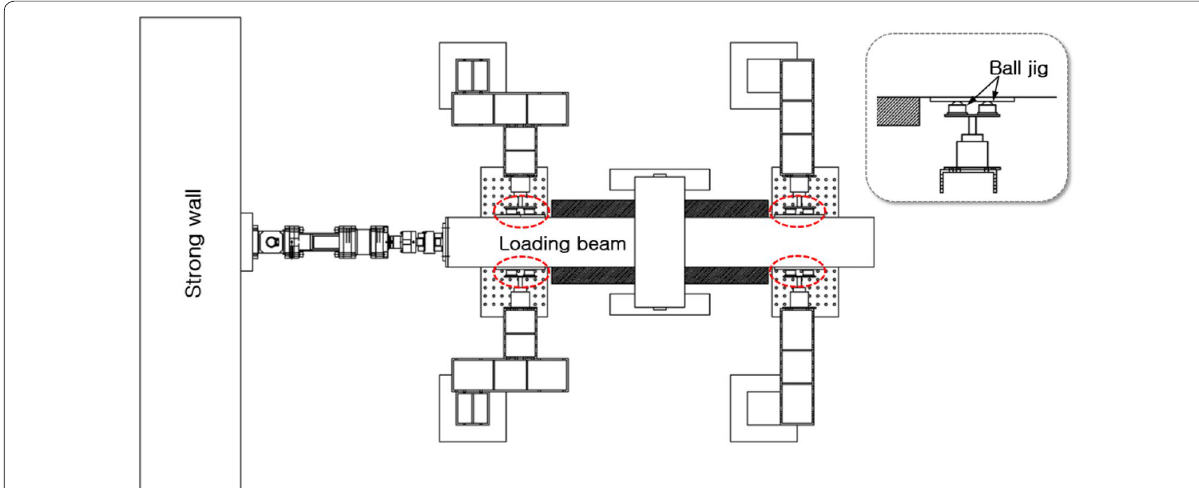
Fig. 7 Guide frame installation for prevention of out‑of‑plane buckling.